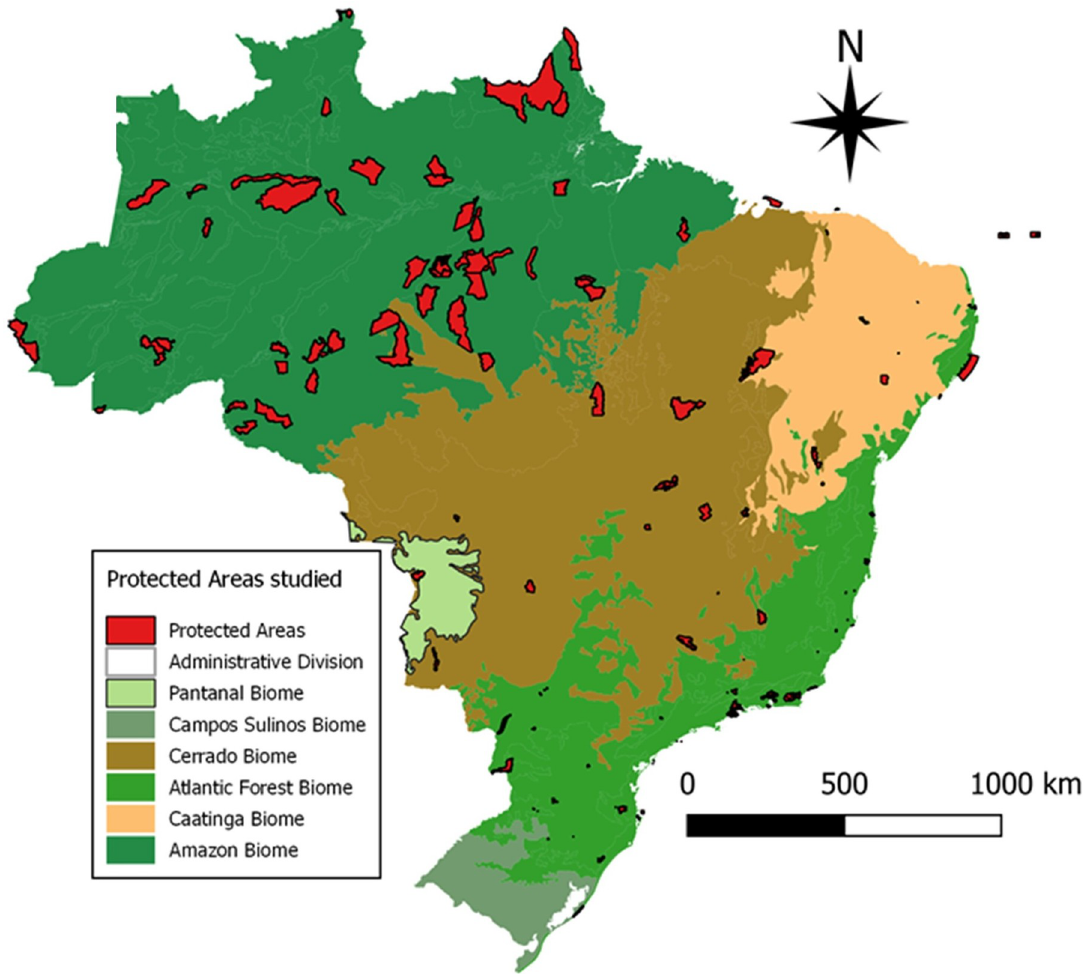
Fig 1. Brazilian biomes and location of the 126 Protected Areas (PAs) that had their management plans evaluated in the present